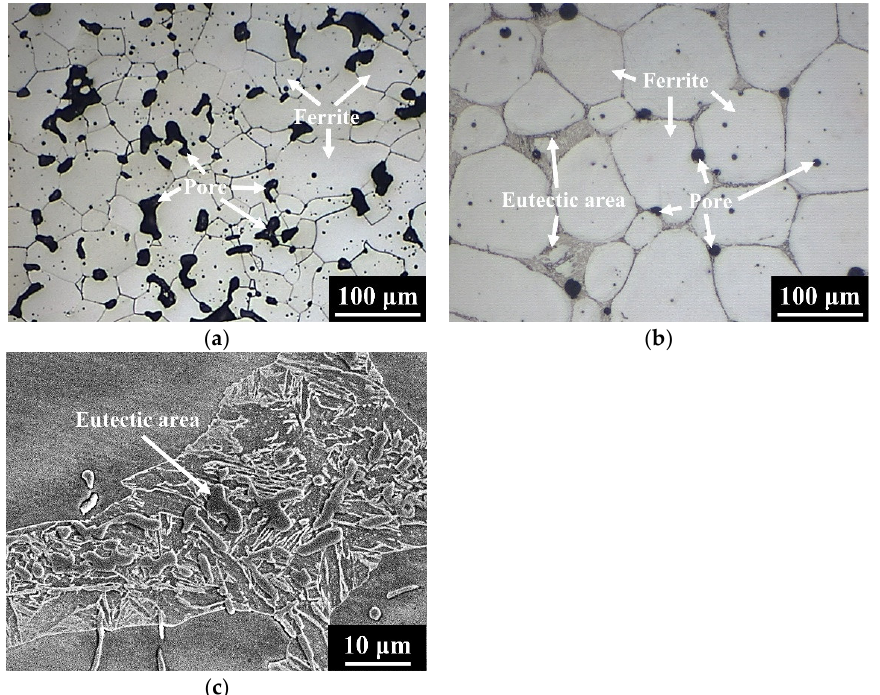
Figure 4. Microstructures of the ( a ) 410L and ( b ) 410L + 0.6B PM stainless steels. ( c ) High magnification of a eutectic area in 410L + 0.6B.